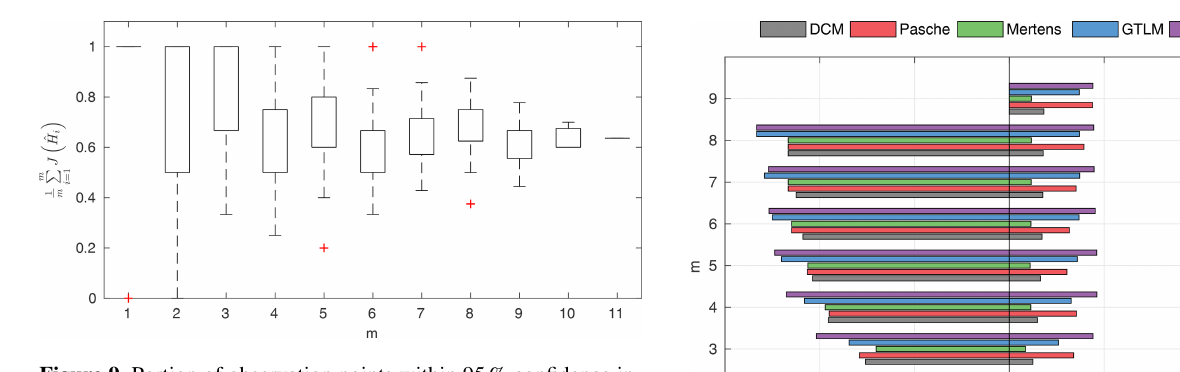
Figure 9. Portion of observation points within 95% confidence in- tervals for the Pasche method as a function of observation points used in parameter identification, presented in the form of box-plots; results for the unsuitable data set for the Pasche method of Rito- backen, spring 2012.